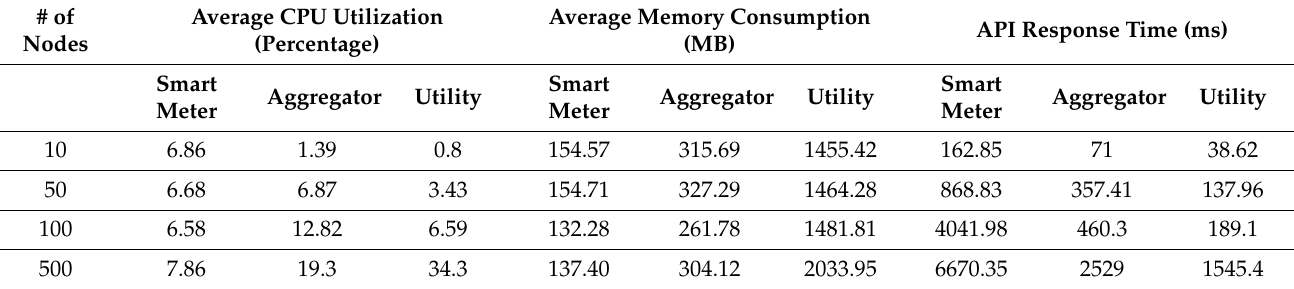
Table 4. Authorization component performance.